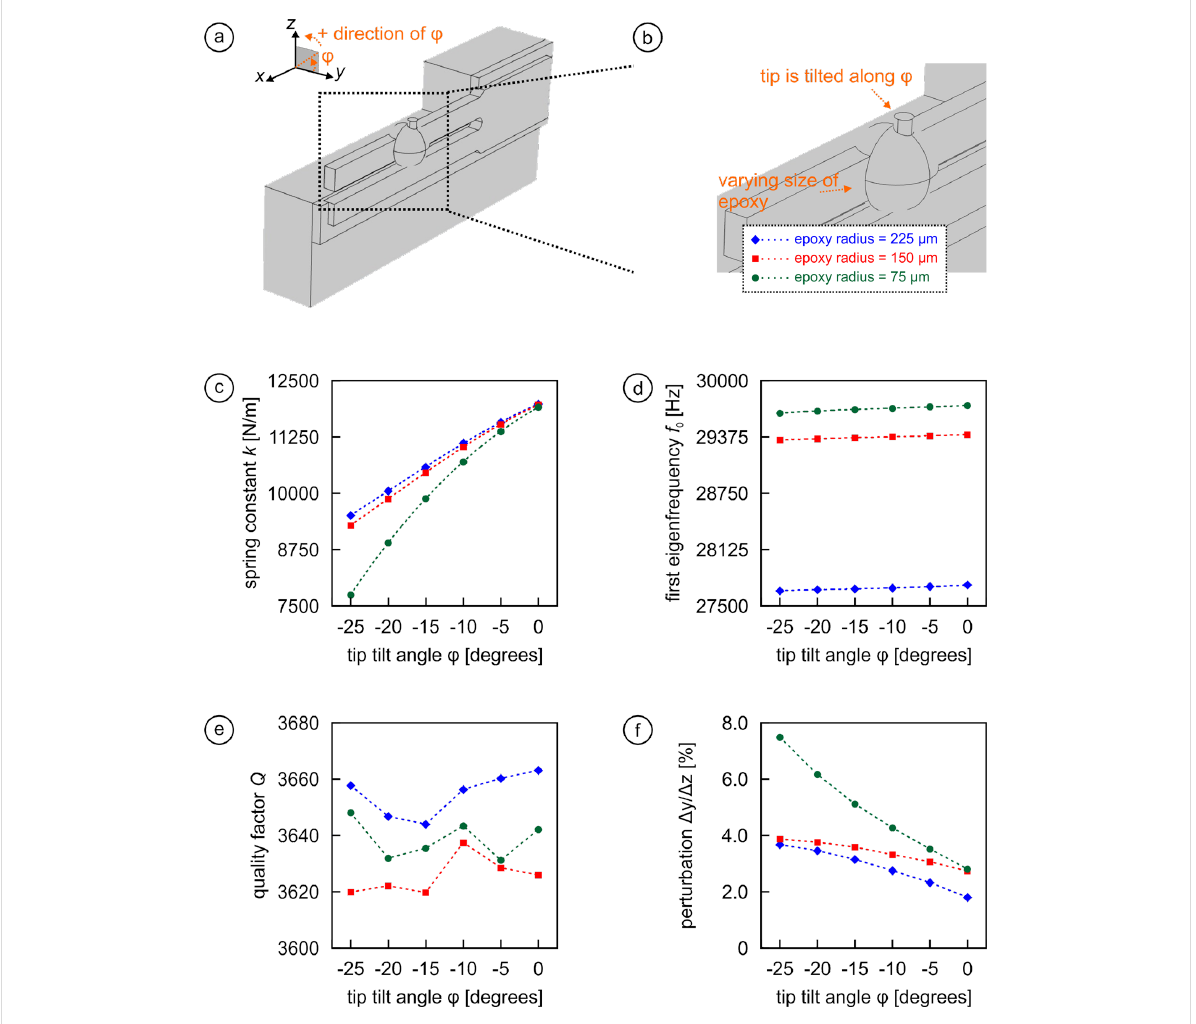
Figure 4: Model for a configuration where the tip is mounted at the half-length point of the free prong at the far side of the prong when viewed from the side of the holder. (a,b) Three-dimensional representations illustrating the geometrical layout. (c–f) Effect of tip tilt on k , f 0 , Q , and Δ y / Δ z for three different epoxy